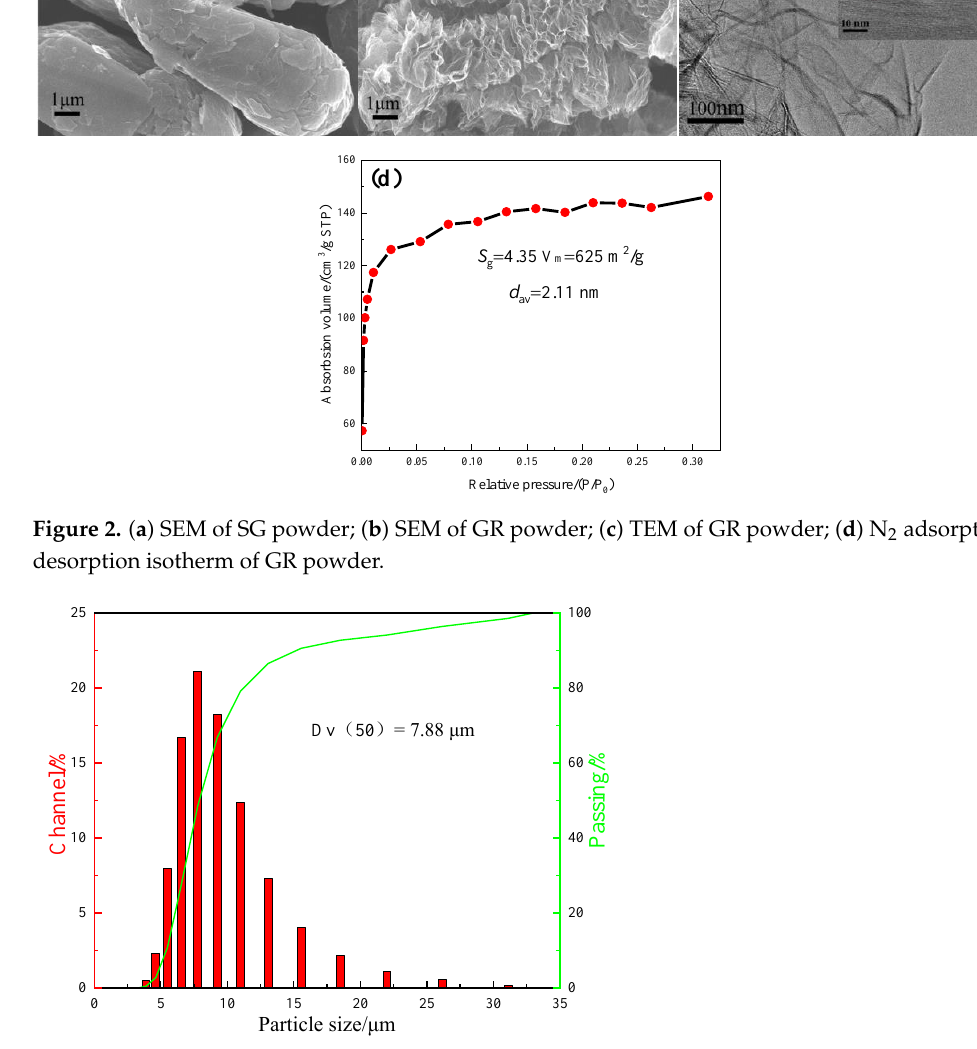
1 0 21 Figure 4. Fourier infrared spectra of SG and GR powders. 3.1.2. Phase Structure and Graphitization Degree of SG/GR/PLA/TPU Composites Figure 5a shows the XRD patterns of six SG/GR/PLA/TPU composites with different contents. Diffraction peaks belonging to PLA/TPU were observed at 2θ = 19.55°, 22.62° and 28.90°, corresponding to (203), (210) and (310) crystal planes, respectively. The C-phase (SG/GR) diffraction peak corresponding to (002) crystal plane (JCPDSNo. 41- 1487) was observed at 2θ = 26.46°. The difference is that the SG/GR peak of (1% SG + 4% GR)/PLA/TPU composite is the smallest, which promotes the crystallization of PLA/TPU. The SG/GR peak of (4% SG + 1% GR)/PLA/TPU composite is closer to the peak intensity of the (210) crystal plane, which is beneficial to the uniform composite of a PLA/TPU matrix. Figure 5b shows the Raman spectra of six SG/GR/PLA/TPU composites with different contents. There were peaks in different degrees around 1346 cm −1 (D-band), 1580 cm −1 (G-band), 2700 cm −1 (G ′ -band) and 2930 cm −1 . Among them, the D-band indicated the defect and disorder of lattice, G-band indicated the tensile vibration of carbon atoms sp 2 hybridization, and G ′ -band indicated the number of layers of graphite sheets (The peak shape moves to the right when there are multiple layers). Generally speaking, the smaller the I D /I G value (the strength ratio of D-band to G-band), the greater the graphitization